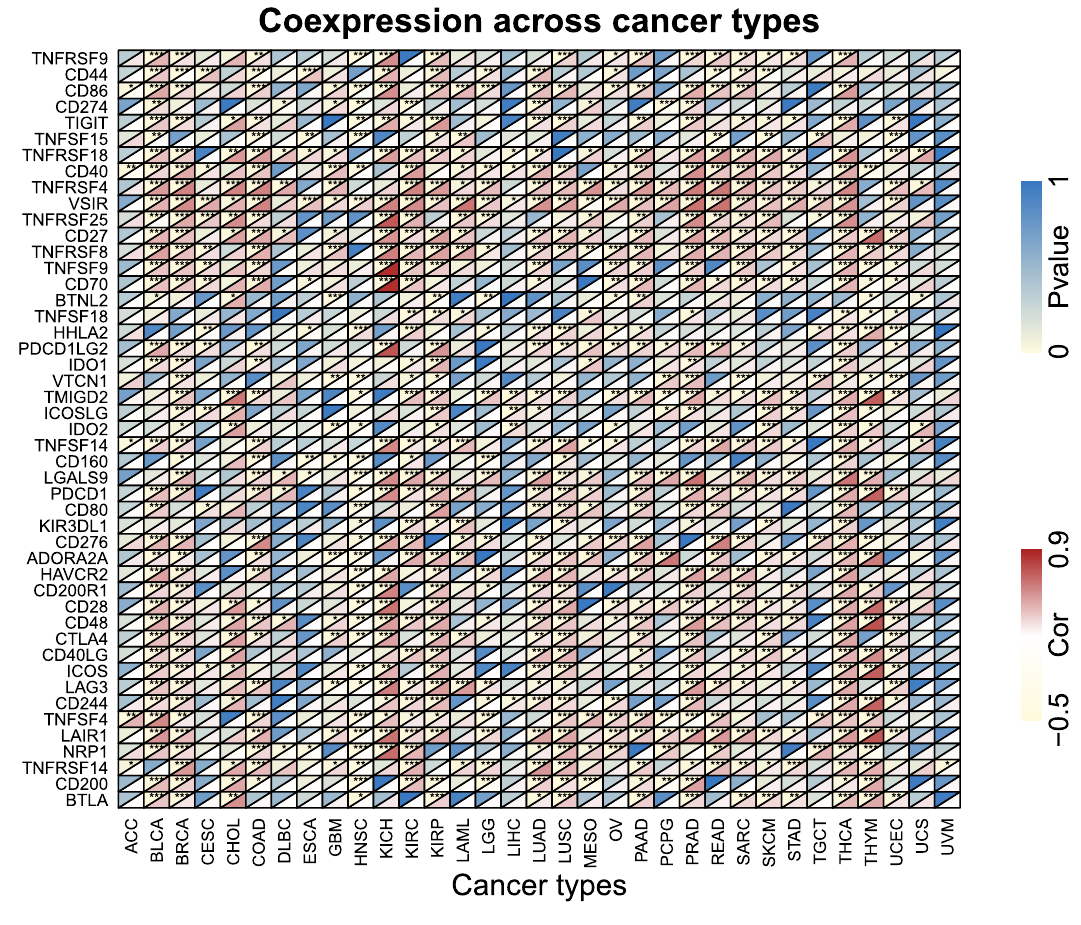
Figure 8. Correlation analysis between PDLIM2 and immune checkpoint genes in 33 cancer types of TCGA dataset by R (3.6.3 version; The R Project for Statistical Computing, Vienna, Austria). The horizontal axis represents cancer types, the vertical axis represents immune genes, each small rectangular module represents the co-expression of immune gene and PDLIM2 gene in cancer, during them, upper left corner asterisk and color represent the P-value, and the lower right corner color represents the Cor. *P < 0.05; **P < 0.01; ***P < 0.001. Cor, correlation coefficient. ACC: adrenocortical carcinoma; BLCA: bladder urothelial carcinoma; COAD: colon adenocarcinoma; HNSC: head and neck squamous cell carcinoma; KICH: kidney chromophobe; KIRP: kidney renal papillary cell carcinoma; LIHC: liver hepatocellular carcinoma; LUAD: lung adenocarcinoma; LUSC: lung squamous cell carcinoma; PRAD: prostate adenocarcinoma; READ: rectum adenocarcinoma; STAD: stomach adenocarcinoma; THCA: thyroid carcinoma; UCEC: uterine corpus endometrial carcinoma; THYM: thymoma; BRCA: breast invasive carcinoma; ESCA: esophageal carcinoma; GBM: glioblastoma multiforme; PCPG: pheochromocytoma and paraganglioma (for interpretation of abbreviations in this figure legend, the reader is referred to the supplementary table of this